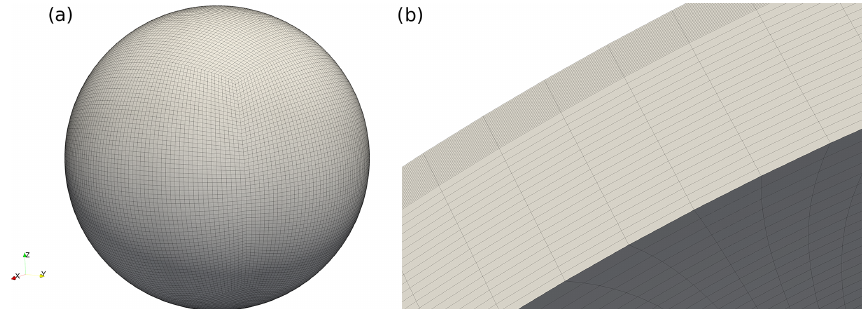
Figure 3. (a) Topology of the ASPECT mesh composed of six blocks. (b) Cross section of the mesh with radial refinement as used in Sect. 4 (here with 30 elements in the top 80km and 20 elements below 80km